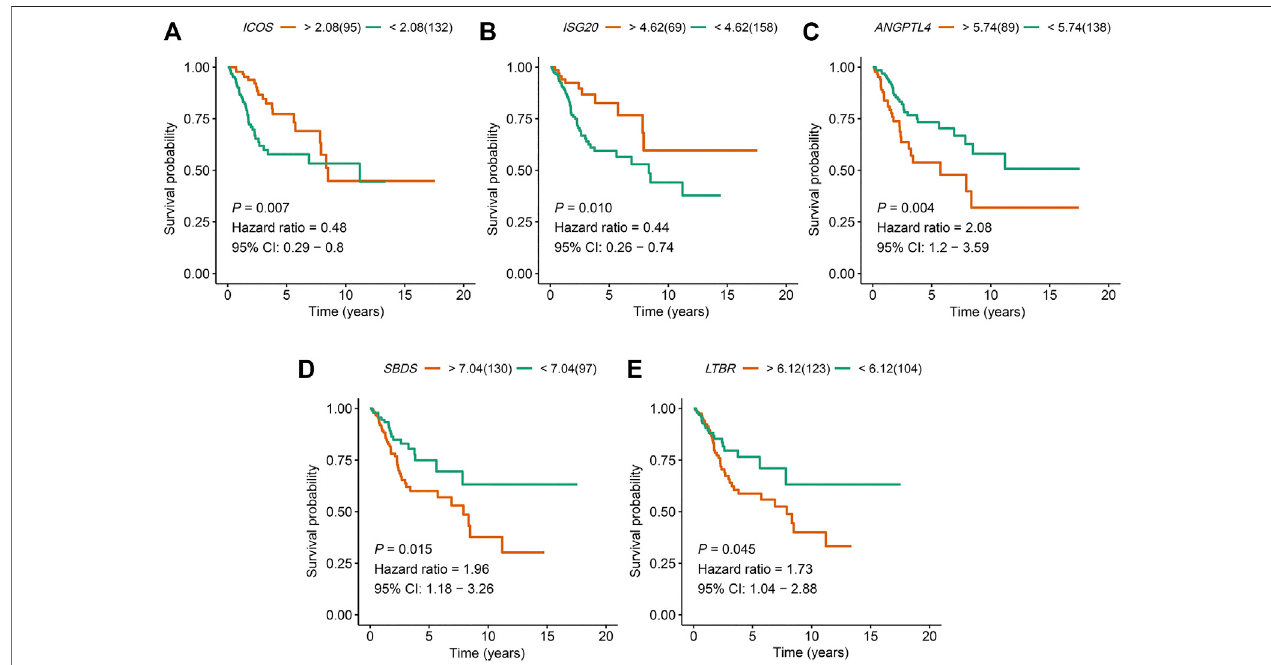
FIGURE 3 | The expression of the fi ve immune genes ICOS , ISG20 , ANGPTL4 , SBDS , and LTBR were signi fi cantly associated with the prognosis of CSCC patients. Kaplan – MeierOS curves for high and lowexpression of (A) ICOS , (B) ISG20 , (C) ANGPTL4 , (D) SBDS ,and (E) LTBR inCSCC patients. ICOS , Inducible T Cell Costimulator ; ISG20 , InterferonStimulatedExonucleaseGene20 ; ANGPTL4 , Angiopoietin Like4 ; SBDS , SBDSRibosome Maturation Factor ; LTBR,LymphotoxinBeta Receptor ; CSCC, cervical squamous cell carcinoma; OS, overall survival.